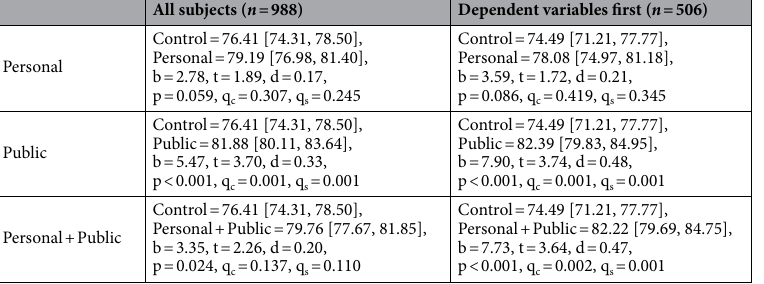
Table 1. Treatment effects on prevention intentions in Study 1. We compare each of our treatments to the control in Study 1. For each treatment, we report mean prevention intentions (with 95% CIs) in the treatment and control conditions, and the treatment effect (both among all subjects, and subjects for whom we measured our dependent variables first).